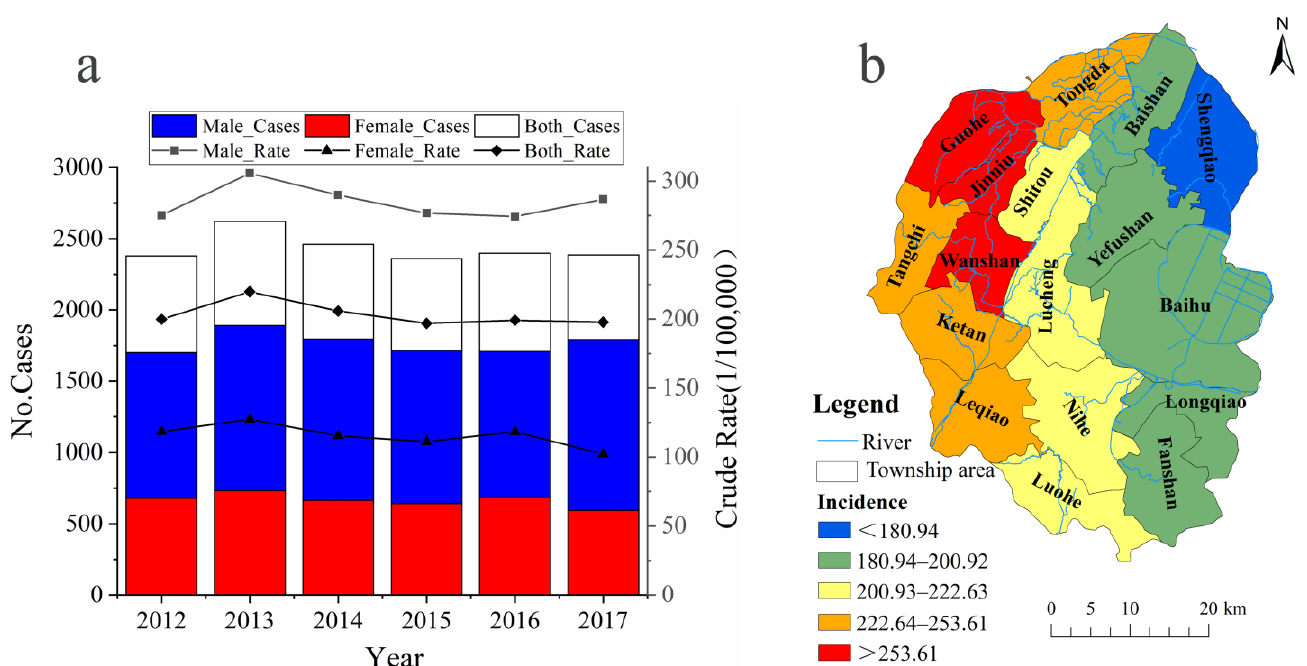
Figure 2. The space ( b ) and time ( a ) distribution of digestive tract cancer in Lujiang County from 2012 to 2017.